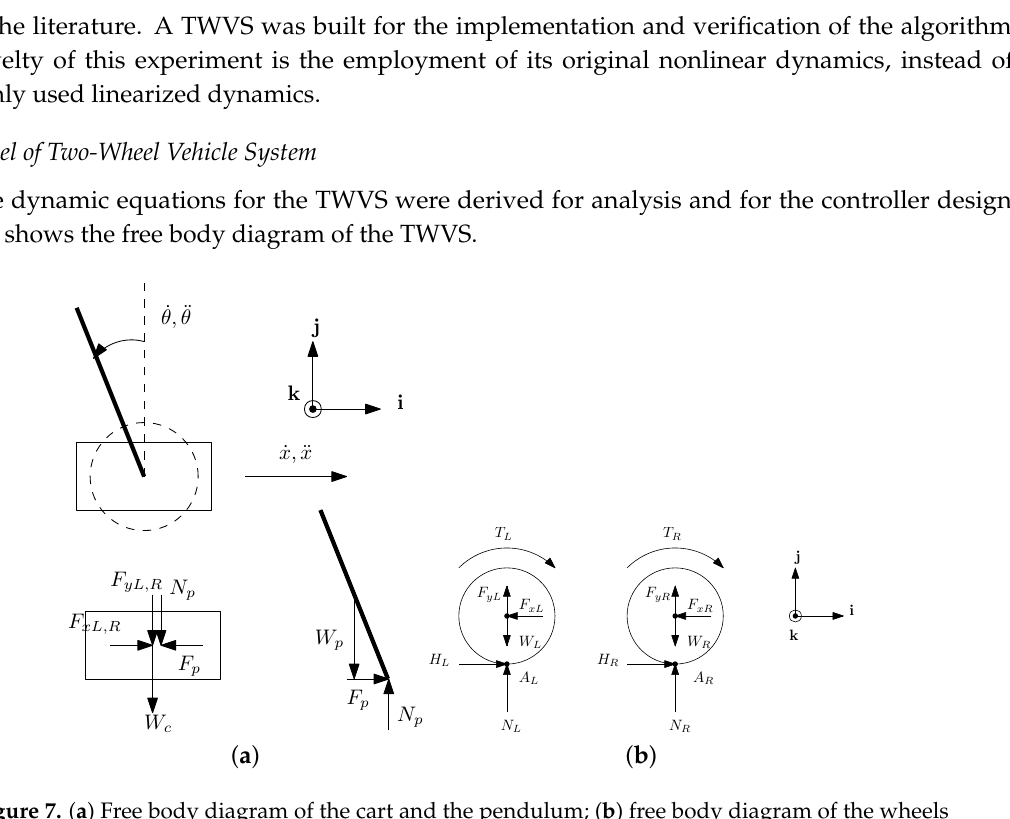
Figure 7. ( a ) Free body diagram of the cart and the pendulum; ( b ) free body diagram of the